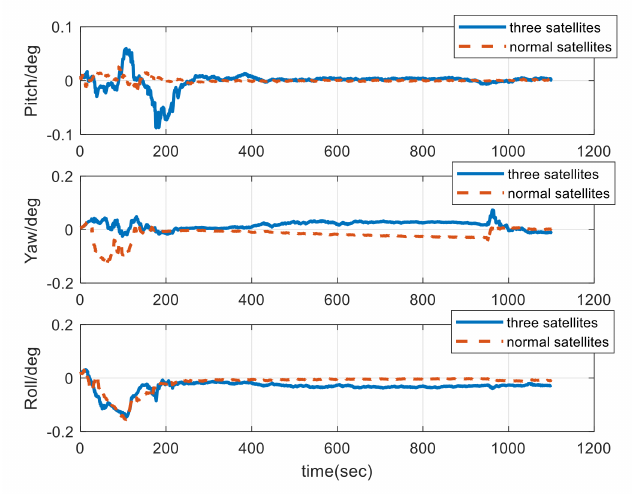
Figure 8. Comparison of attitude errors between normal-number satellites and three satellites.